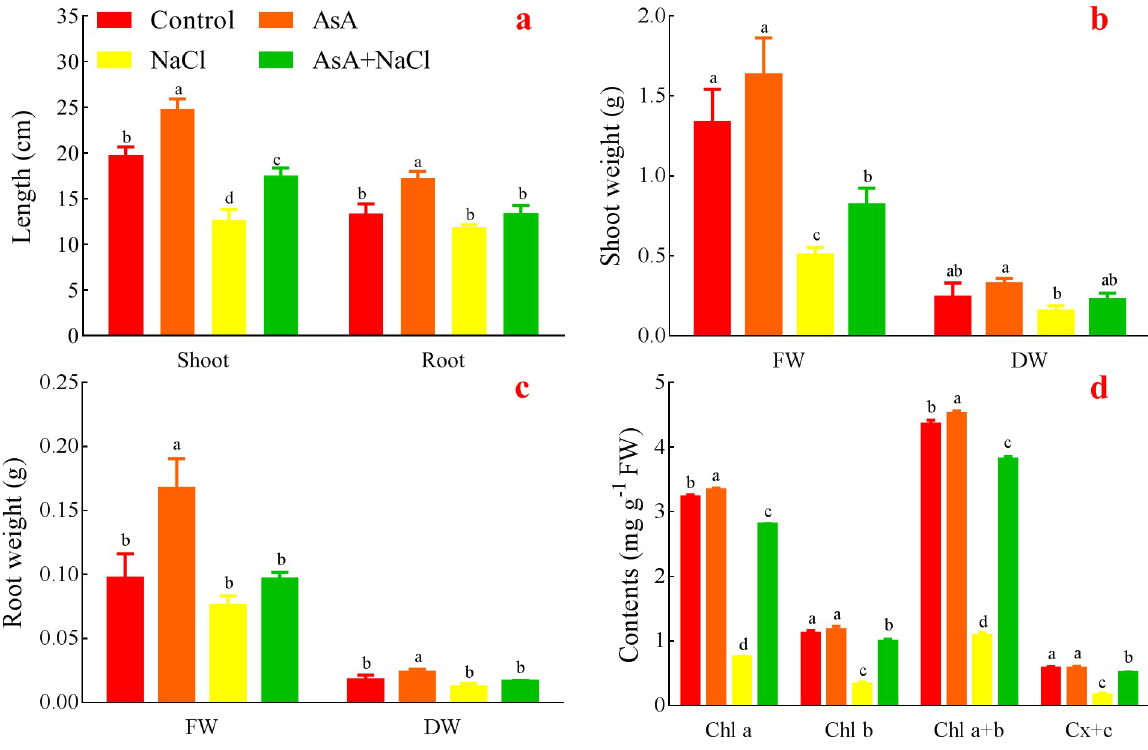
Fig 4. Effects of AsA on shoot length (a), shoot weight (b), root weight (c), and Chl a, Chl b, Chl a+b and Cx+c (d).